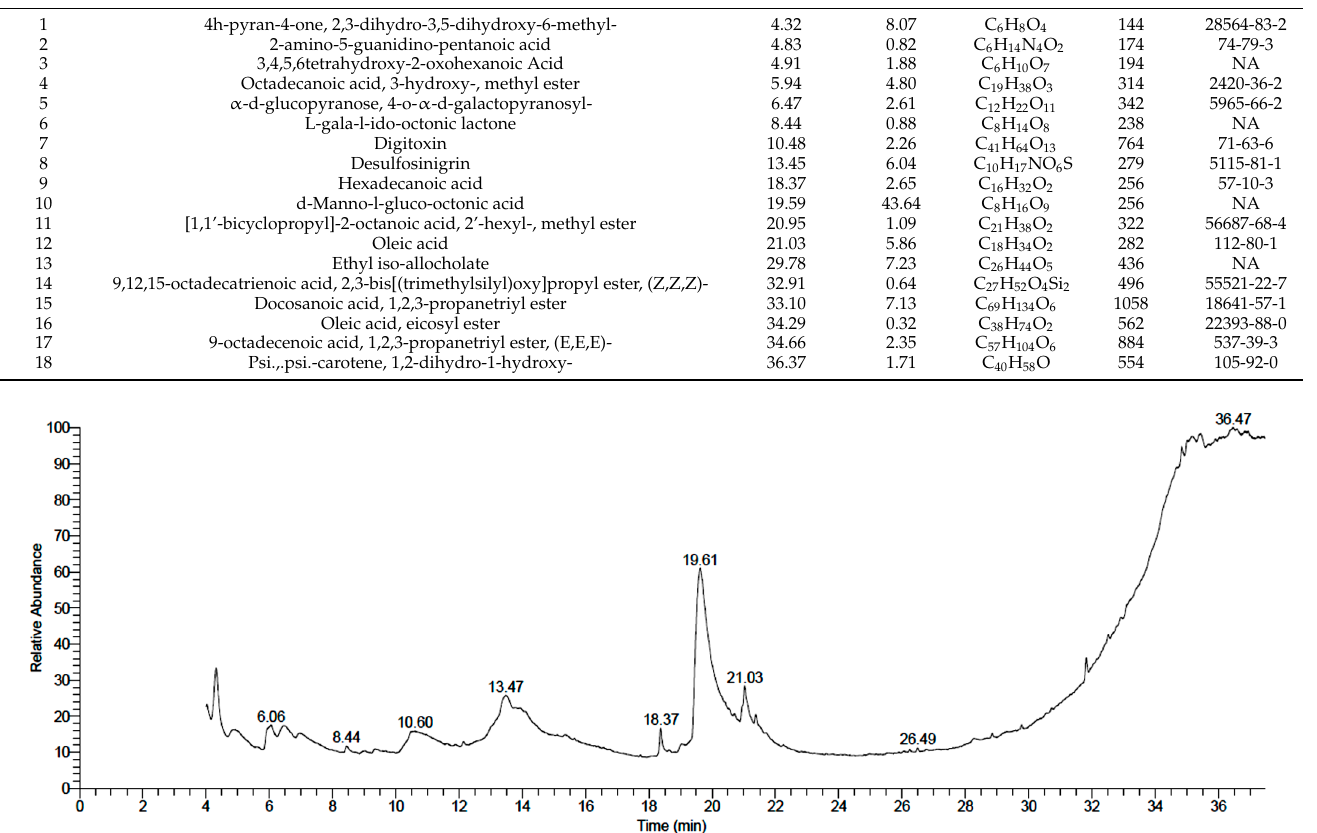
Figure 2. GC–MS chromatogram of methanolic fruit epicarp extract of neem.